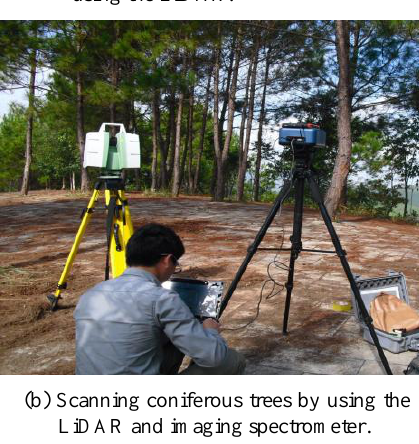
Figure 3.Aconverted two-dimensional image of the laser point cloud data from a single tree.